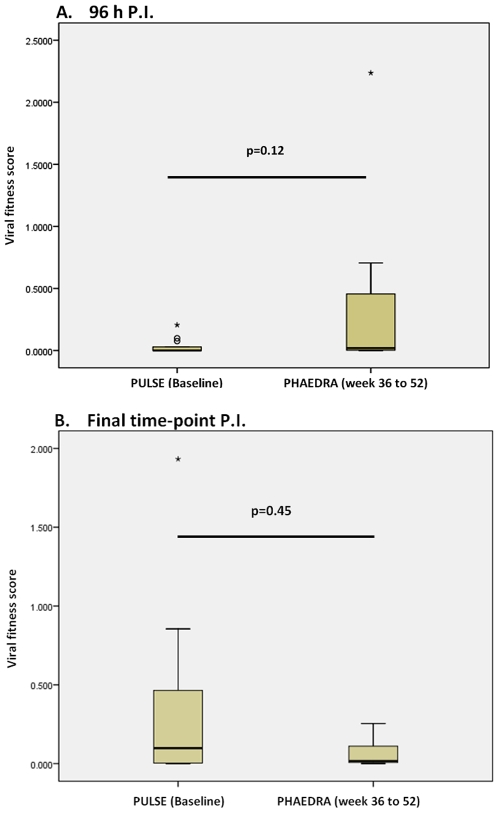
Increased fitness of Baseline isolates obtained from acute HIV-1 infection subjects relative to isolates obtained subsequent to Baseline from early chronic HIV-1 infection subjects.Relative viral fitness scores were calculated for isolates obtained from PULSE and PHAEDRA subjects. Shown on a box-plot are the viral fitness scores generated for the Baseline isolates obtained from 13 PULSE subjects compared with the viral fitness scores of the ‘Late’ isolates obtained from eight PHAEDRA subjects, at 96 h PI (A) and at the final time-point tested (158 h PI for PULSE and 110 h PI for PHAEDRA isolates; B). The box represents the middle 50% of values for the data set; the solid line indicates the median value. The vertical ‘whiskers’ extending from the box respectively indicate the lowest and highest observed values. Outliers are represented by an open circle; extreme outliers are represented by an asterisk. The significance of difference in viral fitness between the two groups at 96 h PI (A; p = 0.12) and the final time-point tested (B; p = 0.45) is shown.